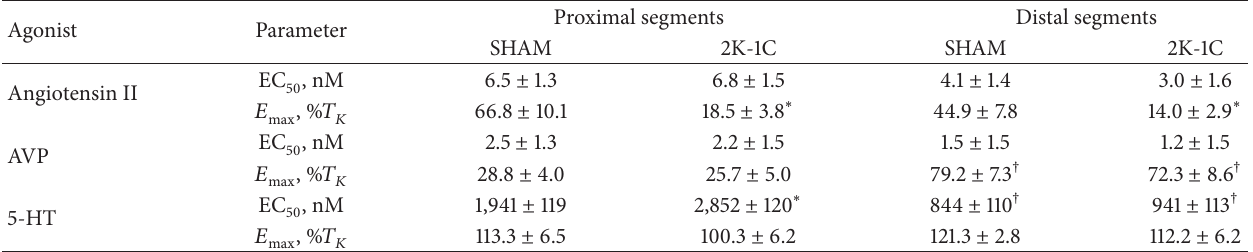
Data are presented as mean ± SEM. AVP: arginine vasopressin. 5-HT: 5-hydroxytryptamine. EC 50 : concentration causing 50% maximal contraction. 𝐸 max % 𝑇 𝐾 : maximal contraction as a percentage of the response elicited by 80mMK + . There were 8 artery segments in each group. ∗ 𝑃 < 0.05 in 2K-1C versus SHAM; † 𝑃 < 0.05 in distal versus proximal segments.